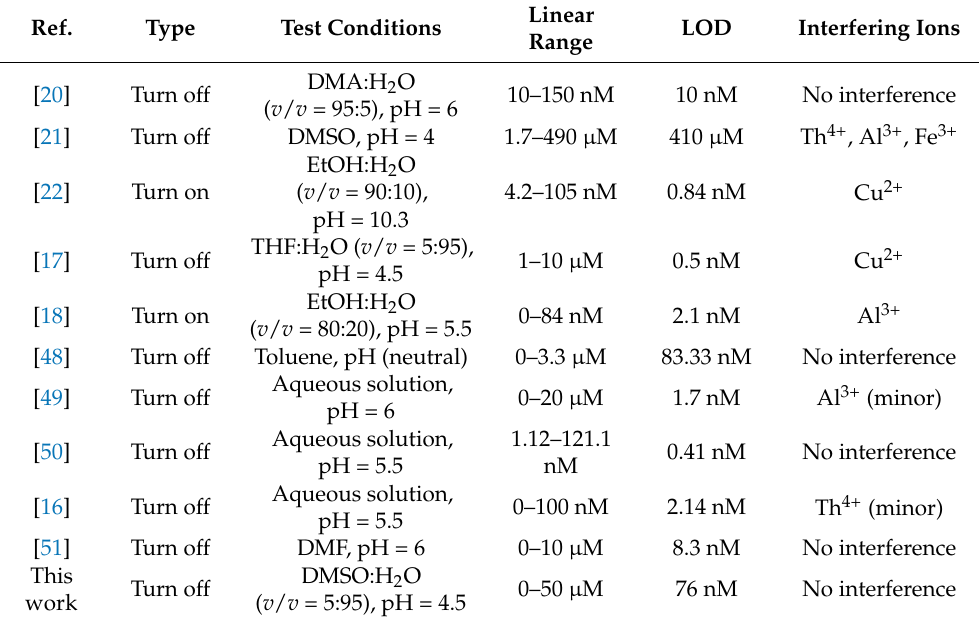
Table 2. Comparison of present work with the literature